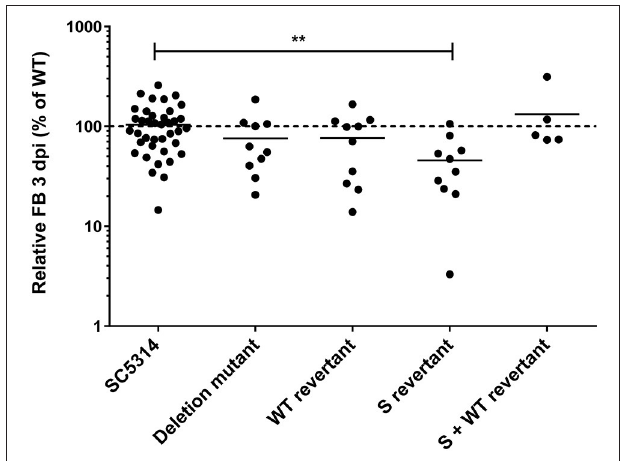
FIGURE 3 | Role of the 885 bp-truncated orf19.2646 on mouse kidney fungal burden (FB). For each individual mouse, the FB in the kidneys is expressed as a percentage relative to the mean of the wild-type group in the same experiment. All experiments are pooled in this graph. The mean value of each group is indicated with a black bar. The dotted line indicates the level of the mean of the wild-type strain set at 100%. Each mutant was tested twice using five mice each time (except for S + WT revertant and SC5314 wild-type strains). Statistical analyses were performed using a Mann–Whitney test to assess CFU differences relative to SC5314 (GraphPad Prism 7.02). The stars indicate the level of statistical significance: ** p < 0.01. S stands for orf19.2646 “short” version of 885